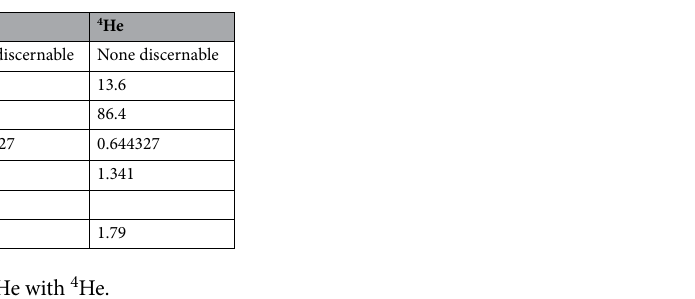
Table 1. PGS comparison